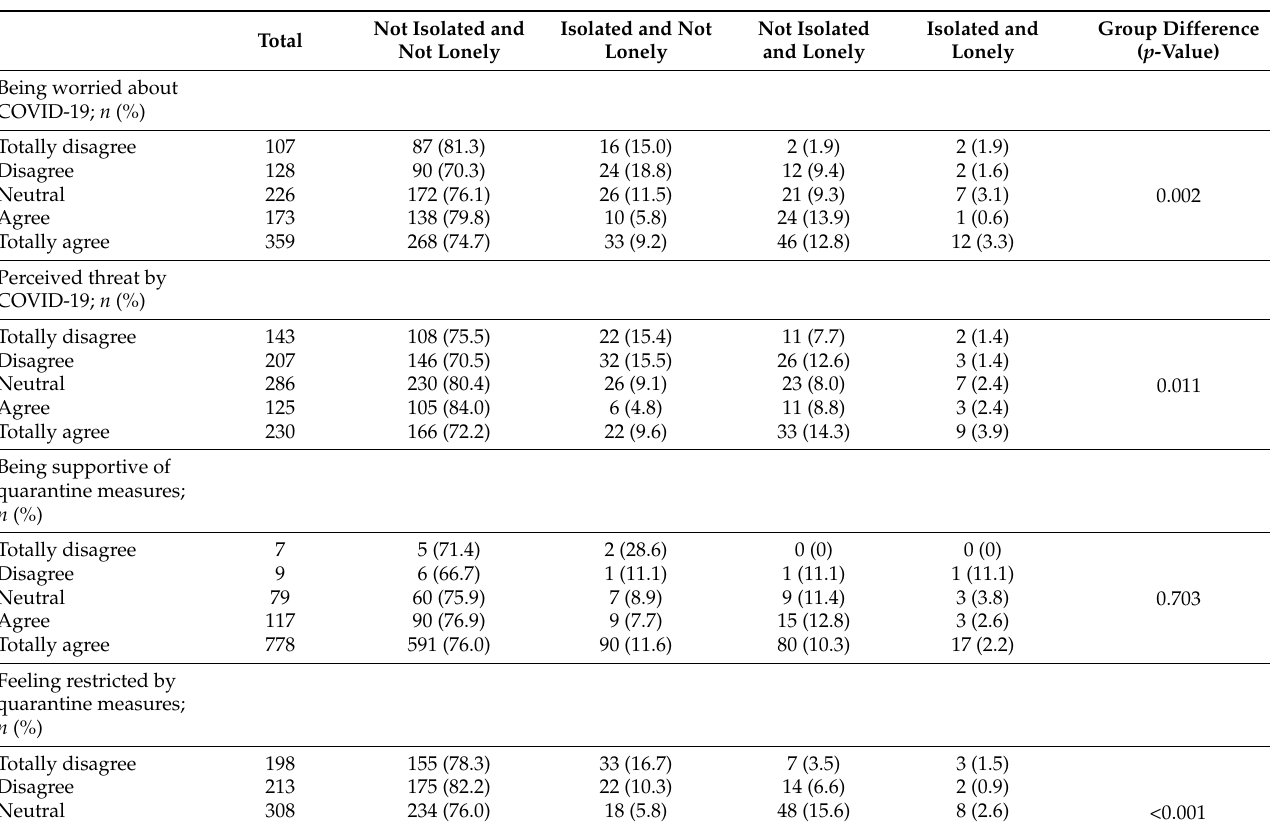
Table 2. Attitudes towards COVID-19 and resilience and depression scores by social isolation/loneliness subgroups.